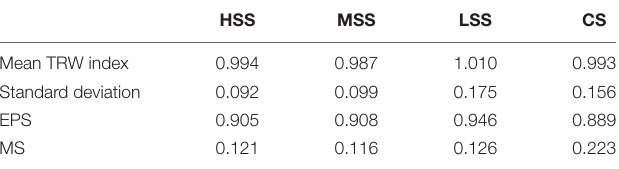
TABLE 2 | Statistical parameters of the indexed average chronologies of the four areas.